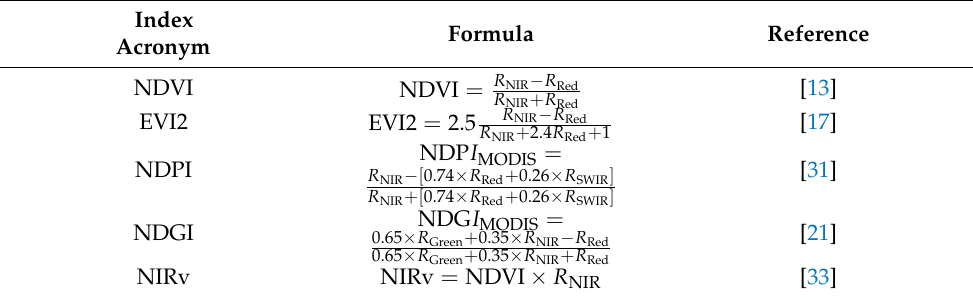
Table 1. Derivation of vegetation indices used in the